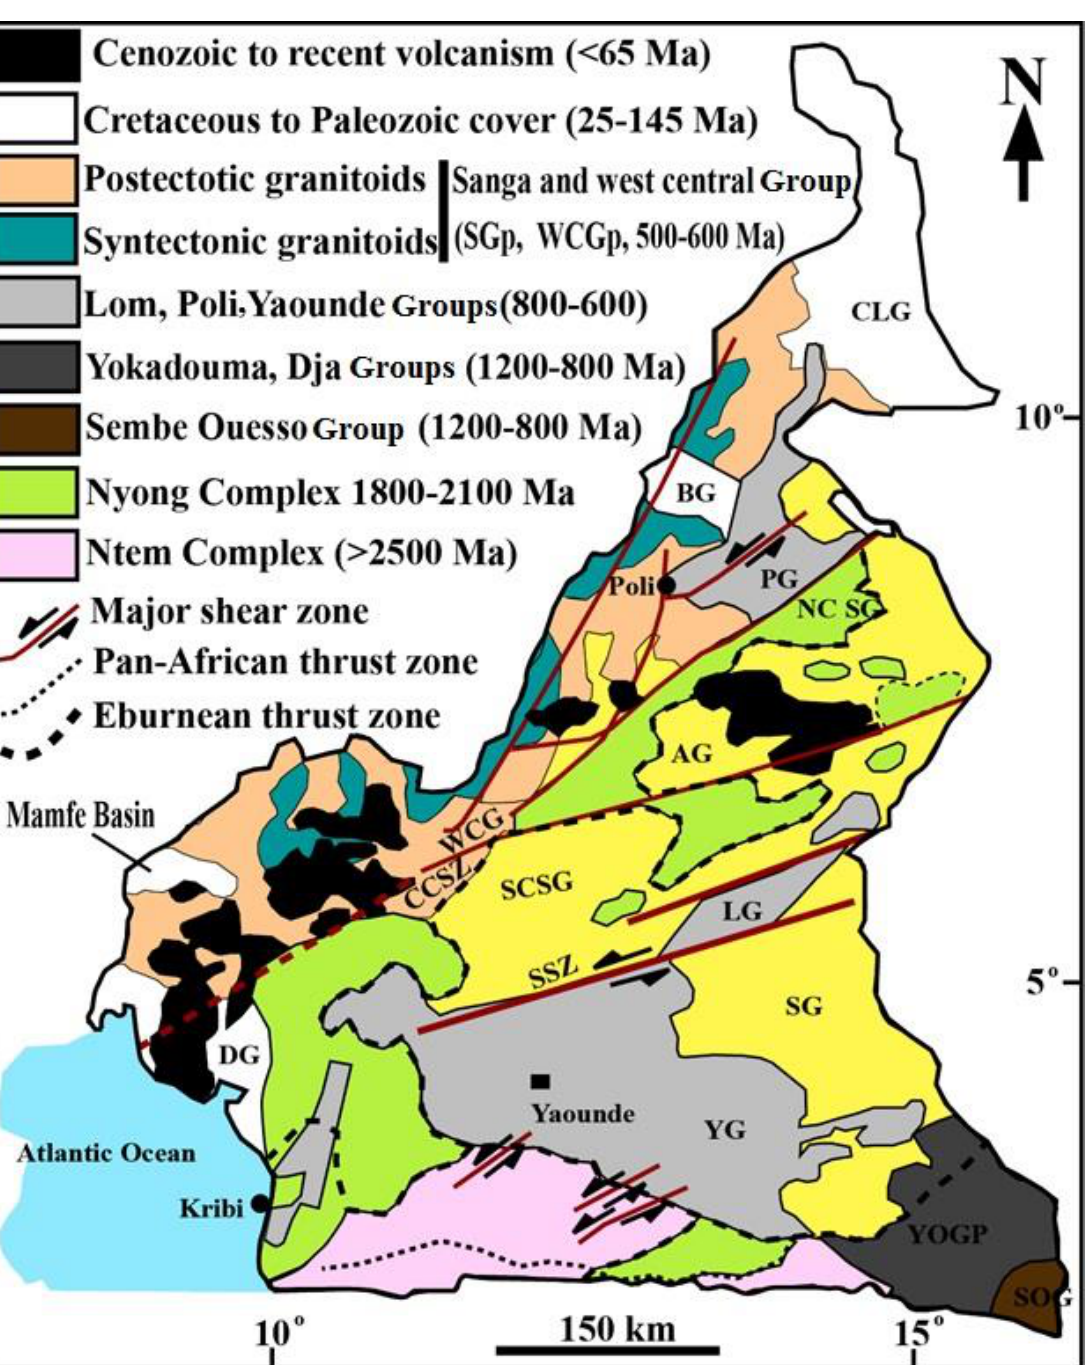
Figure 2. Sketch geological map of Cameroon (adapted from [38]). Oubanguide Complex: NCSG: Northern Cameroon SGp (PG: Poli Group, AG: Adamawa Group, WCG: West Cameroon Group); SCSG: Southern Cameroon SGp (YG: Yaoundé Group, LG: Lom Group, SG: Sanaga Group); SECSGp: Southeastern Cameroon SGp (DG: Dja, YoGroup: Yokadouma, S.O.Group: Sembe Ouesso Group); CCSZ: Centre Cameroon shear zone; SSZ: Sanaga shear zone; Sedimentary cover: (CLG: Chad Lake Group; BG: Benue Group; MG: Manfe Group; DG: Douala Group); B: Cameroon main litho-structural units.